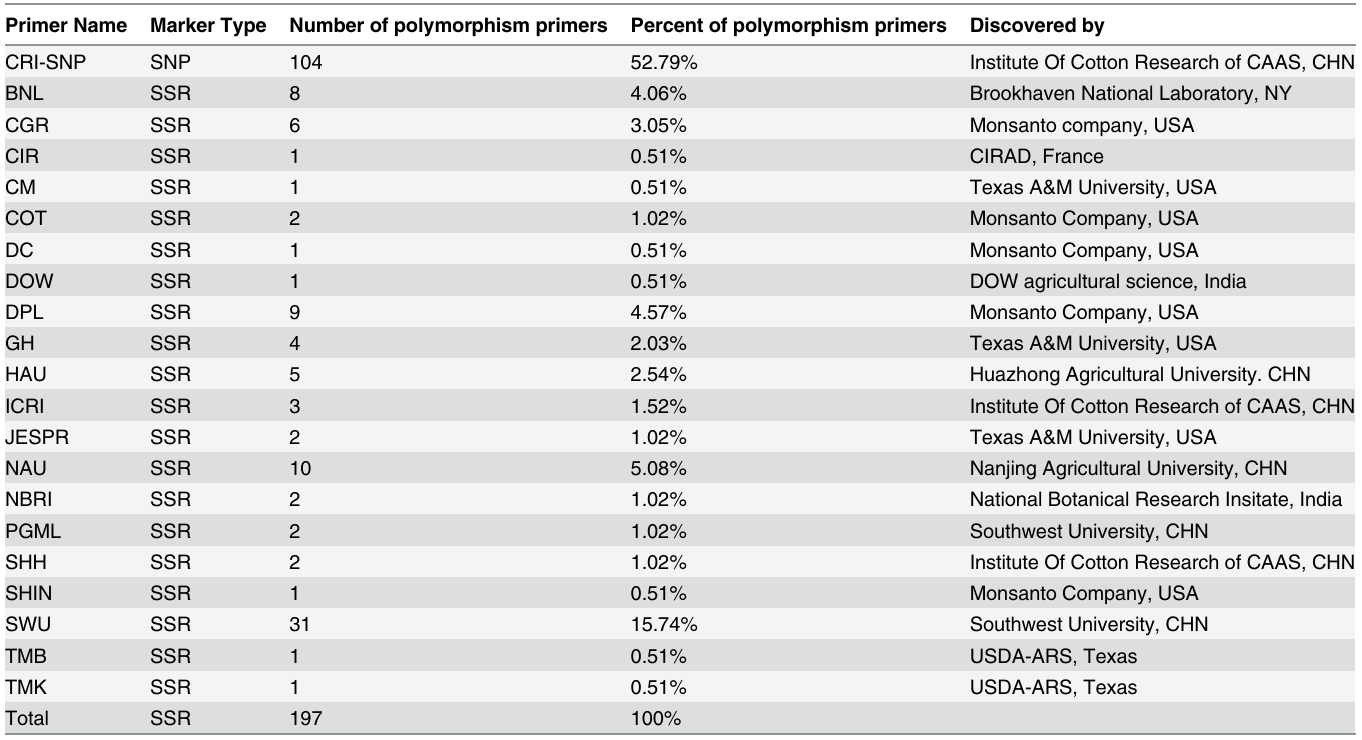
Table 2. The information of the SSR markers and SNP markers on the linkage map. Primer Name Marker Type Number of polymorphism primers Percent of polymorphism primers Discovered by